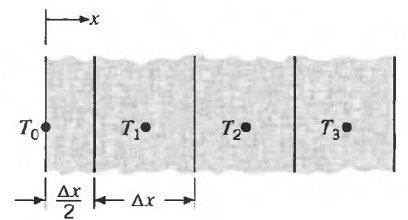
Figure 2. Scheme of the cordwood layers.